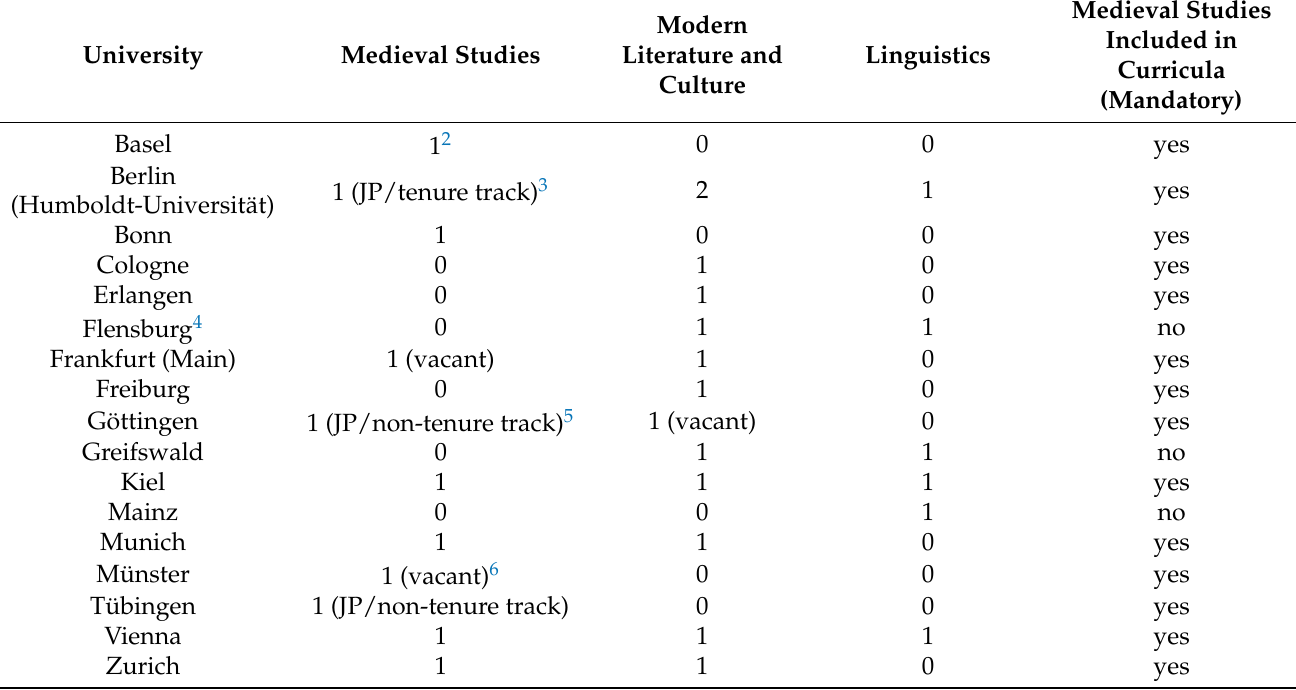
Table 1. Scandinavian Studies in the German-speaking area; number and denomination of professor- ships; inclusion of medieval studies in B.A. curricula.